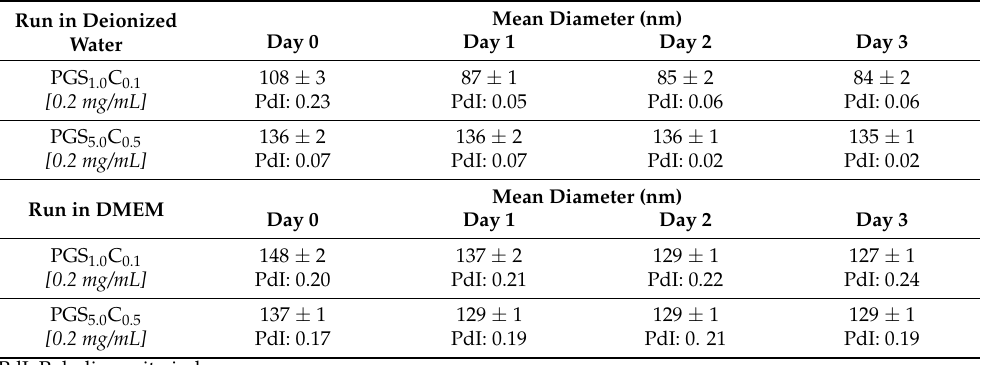
Table 2. PGS 1.0 C 0.1 , PGS 5.0 C 0.5 recorded mean diameters at different times from sample preparation in deionized water and DMEM.